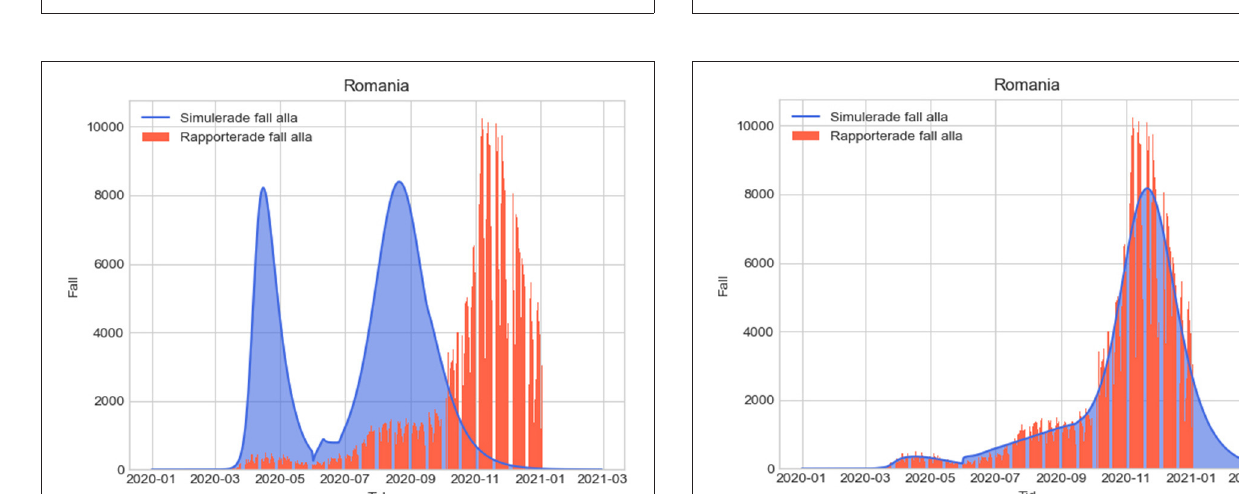
FIGURE 1 | L1: Epidemiologic evolution without any social distancing measures. Total unreported cases 2020-2021: 14,260,483.4; total unreported